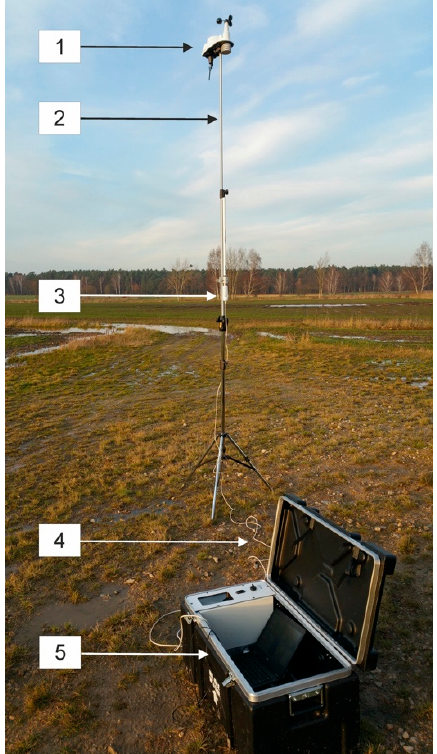
Figure 1. View of measuring station and weather stations, where: 1—Vantage Vue 6250EU weather station; 2—telescopic tripod; 3—ProEter104 omnidirectional antenna; 4—connector linking antenna to router and 5—measurement case with Wi-Fi 2.4 GHz access point.